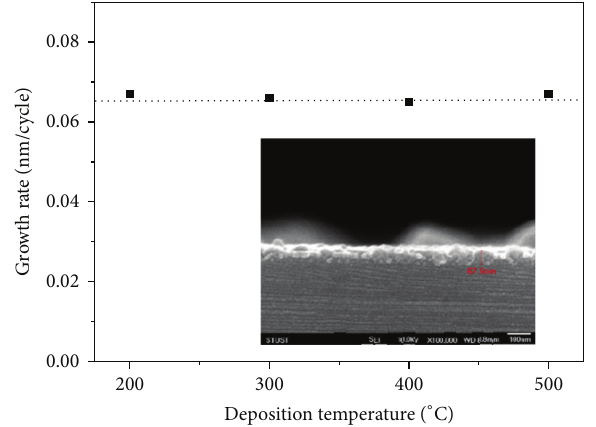
Figure 3: ALD TiO 2 growth rate at temperature 200 ∘ C, 300 ∘ C, 400 ∘ C, and 500 ∘ C is 0.066 nm per cycle due to self-limiting growth. Inset is the cross-section SEM image.